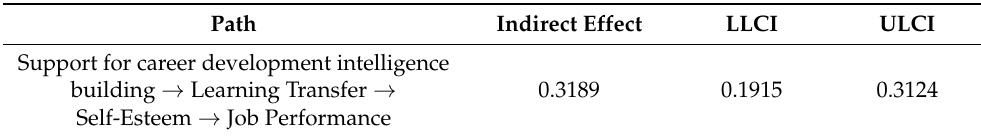
Table 6. PROCESS Macro: Analysis